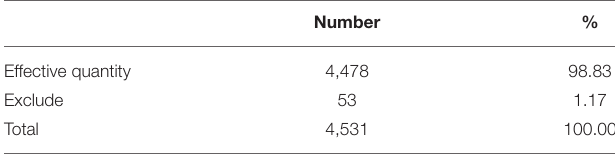
TABLE 2 | Summary of questionnaire processing.